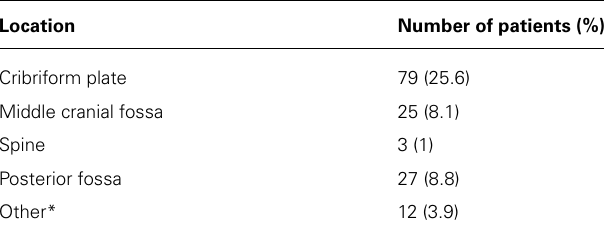
Table 2 |Types of major deviations for the 308 evaluable